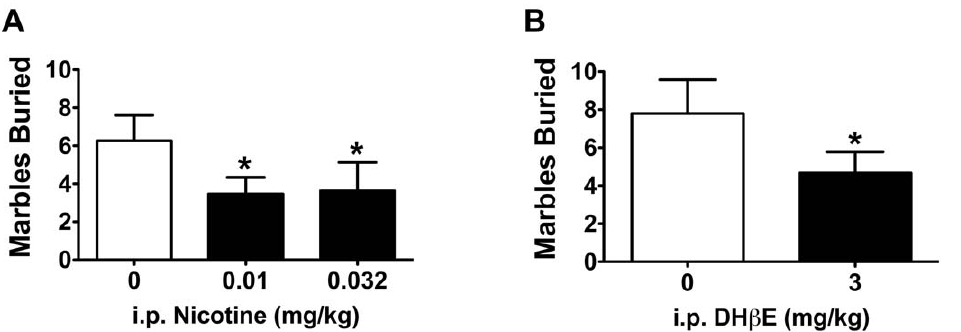
Figure 3. Nicotine and DH b E resulted in fewer marbles buried. A) The 0.01 and 0.032 mg/kg i.p. nicotine that promoted anxiolytic-like behavior in the CER task also resulted in a significant reduction in digging behavior as measured by fewer marbles buried compared to when mice were administered saline (n=14). B) Similarly, mice treated with 3 mg/kg i.p. DH b E also buried less marbles compared to when they received saline treatment (n=15). Data are presented as means 6 SEM; * p , 0.05 compared to when mice received saline control